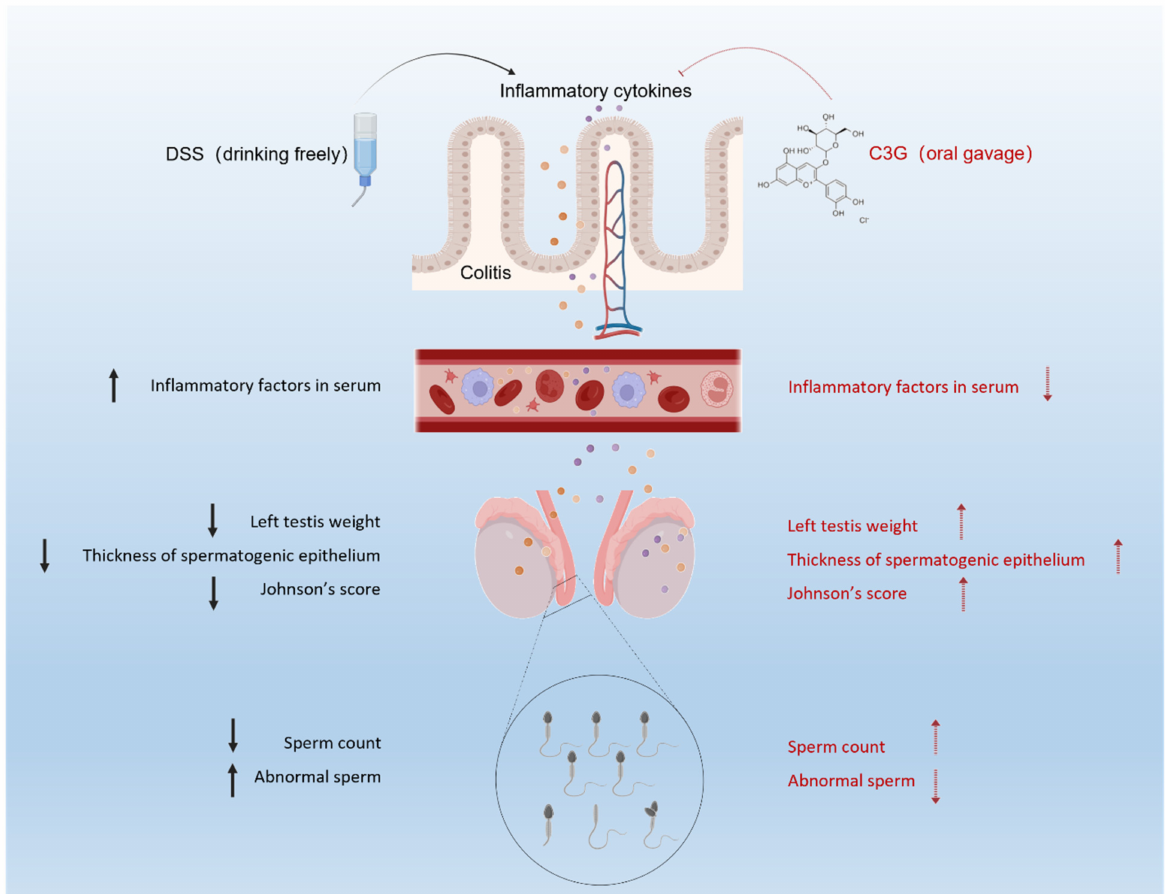
Figure 8. Schematic diagram of C3G improves the impaired fertility of mice with colitis by inhibiting inflammatory cytokines through the blood–testis